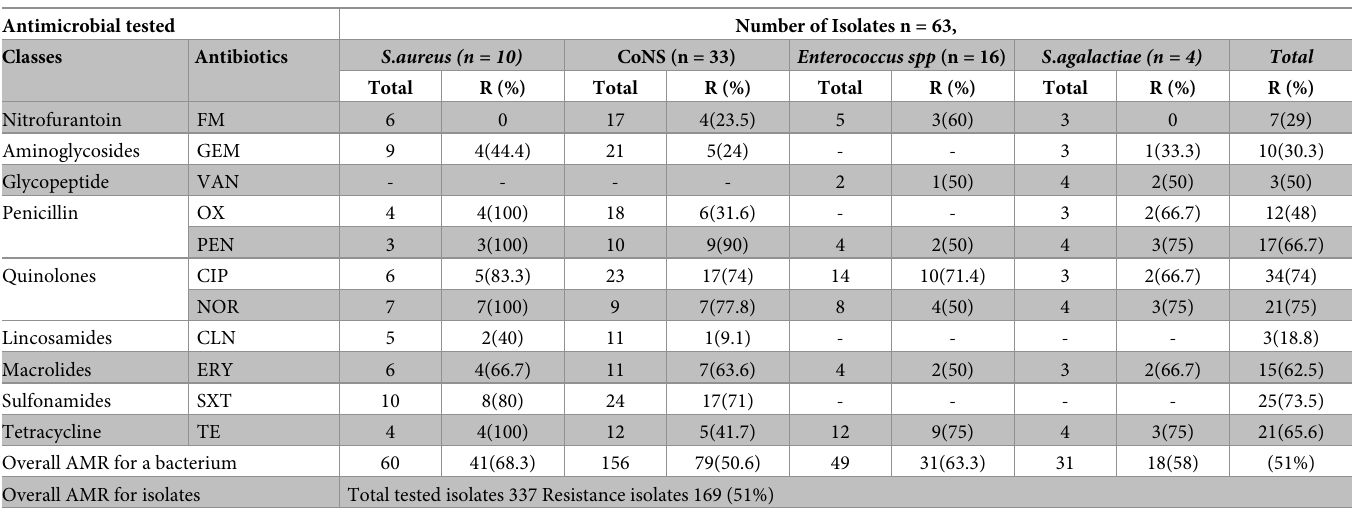
Table 3. Resistance profiling of gram-positive bacteria identified from UTI patients.